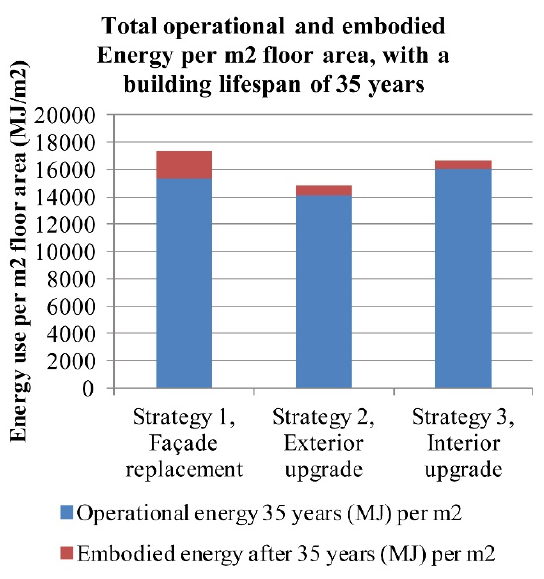
Figure 13. Operational and embodied energy per m 2 floor area, per strategy, for a lifespan of 35 years for the top corner apartment of the case study